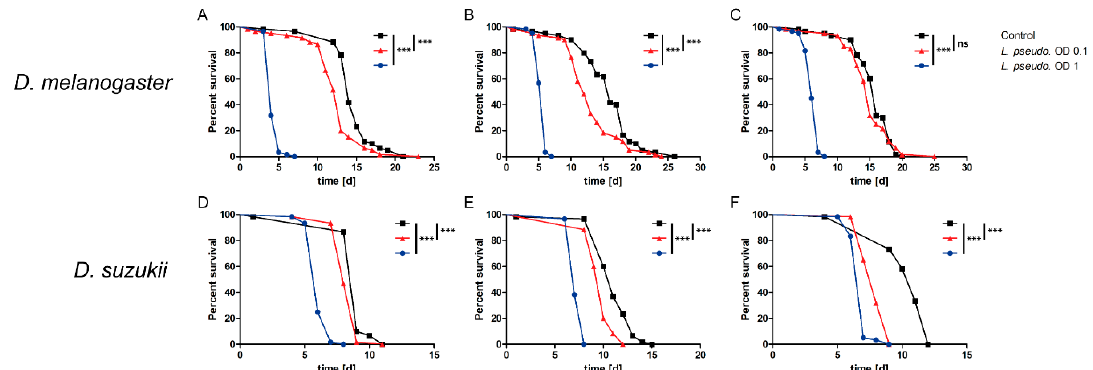
Figure 1. Survival curves for the oral infection of Drosophila melanogaster and D. suzukii with Leuconostoc pseudomesenteroides. Adult flies (3–10 days old) were fed on bacterial suspensions with an optical density (OD 600 ) of 1 or 0.1, or a sucrose control. Each survival assay was carried out three times (biological replicates) with three technical replicates (n = 540). A logrank test was used for statistical analysis. ( A – C ) All three biological replicates of survival assays with D. melanogaster . ( D – F ) All three biological replicates of survival assays with D. suzukii . Statistical significance is indicated as follows: p ≤ 0.0009 ***; p ≤ 0.009 **; p ≤ 0.09 *; ns, not significant.